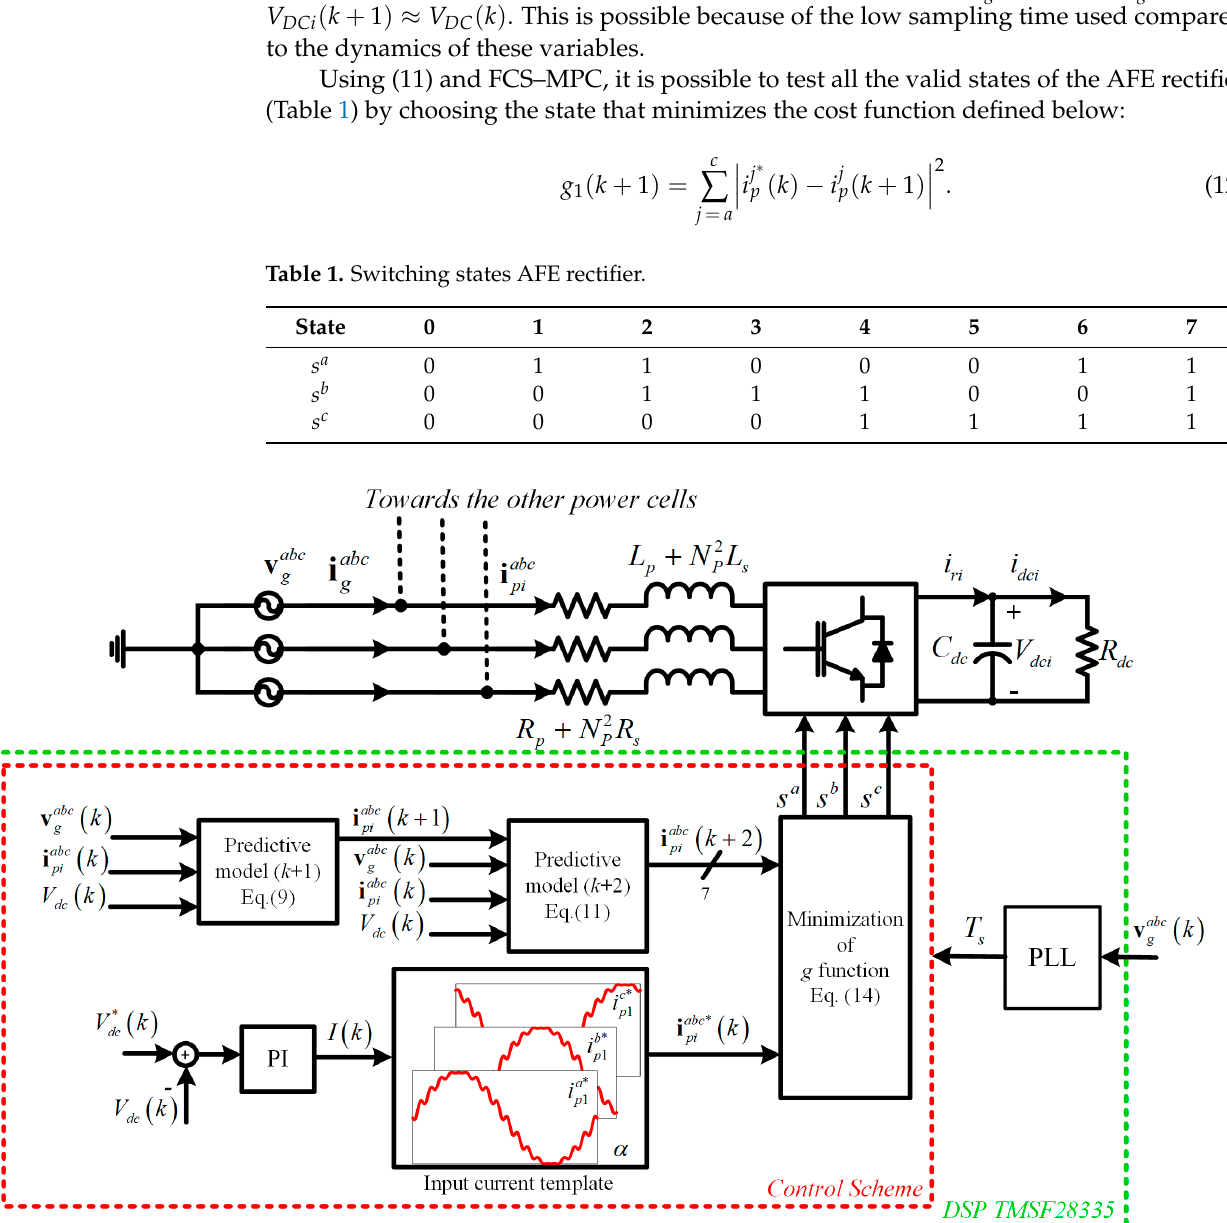
(12) The cost function defined in (12) corresponds to the control of the input current in each AFE rectifier.